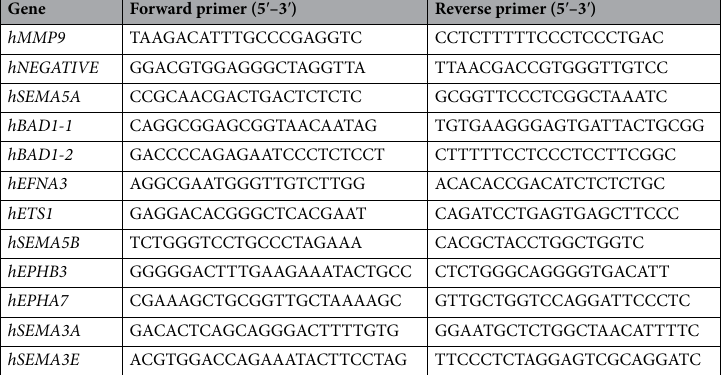
Table 4. The list of primers used in chromatin immunoprecipitation qPCR assay in SH-SY5Y